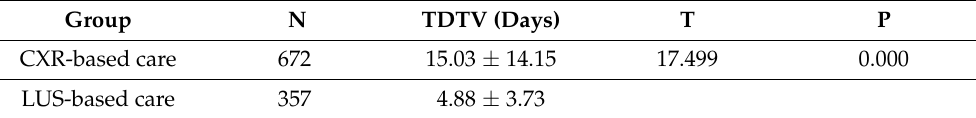
Table 1. The influence of LUS-based care on the duration neonatal mechanical ventilation ( x ± sd). Group N TDTV (Days) T P CXR-based care LUS-based care 357